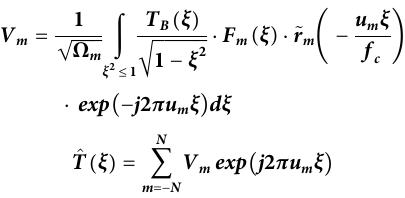
FIGURE 1 Schematic diagram of binary